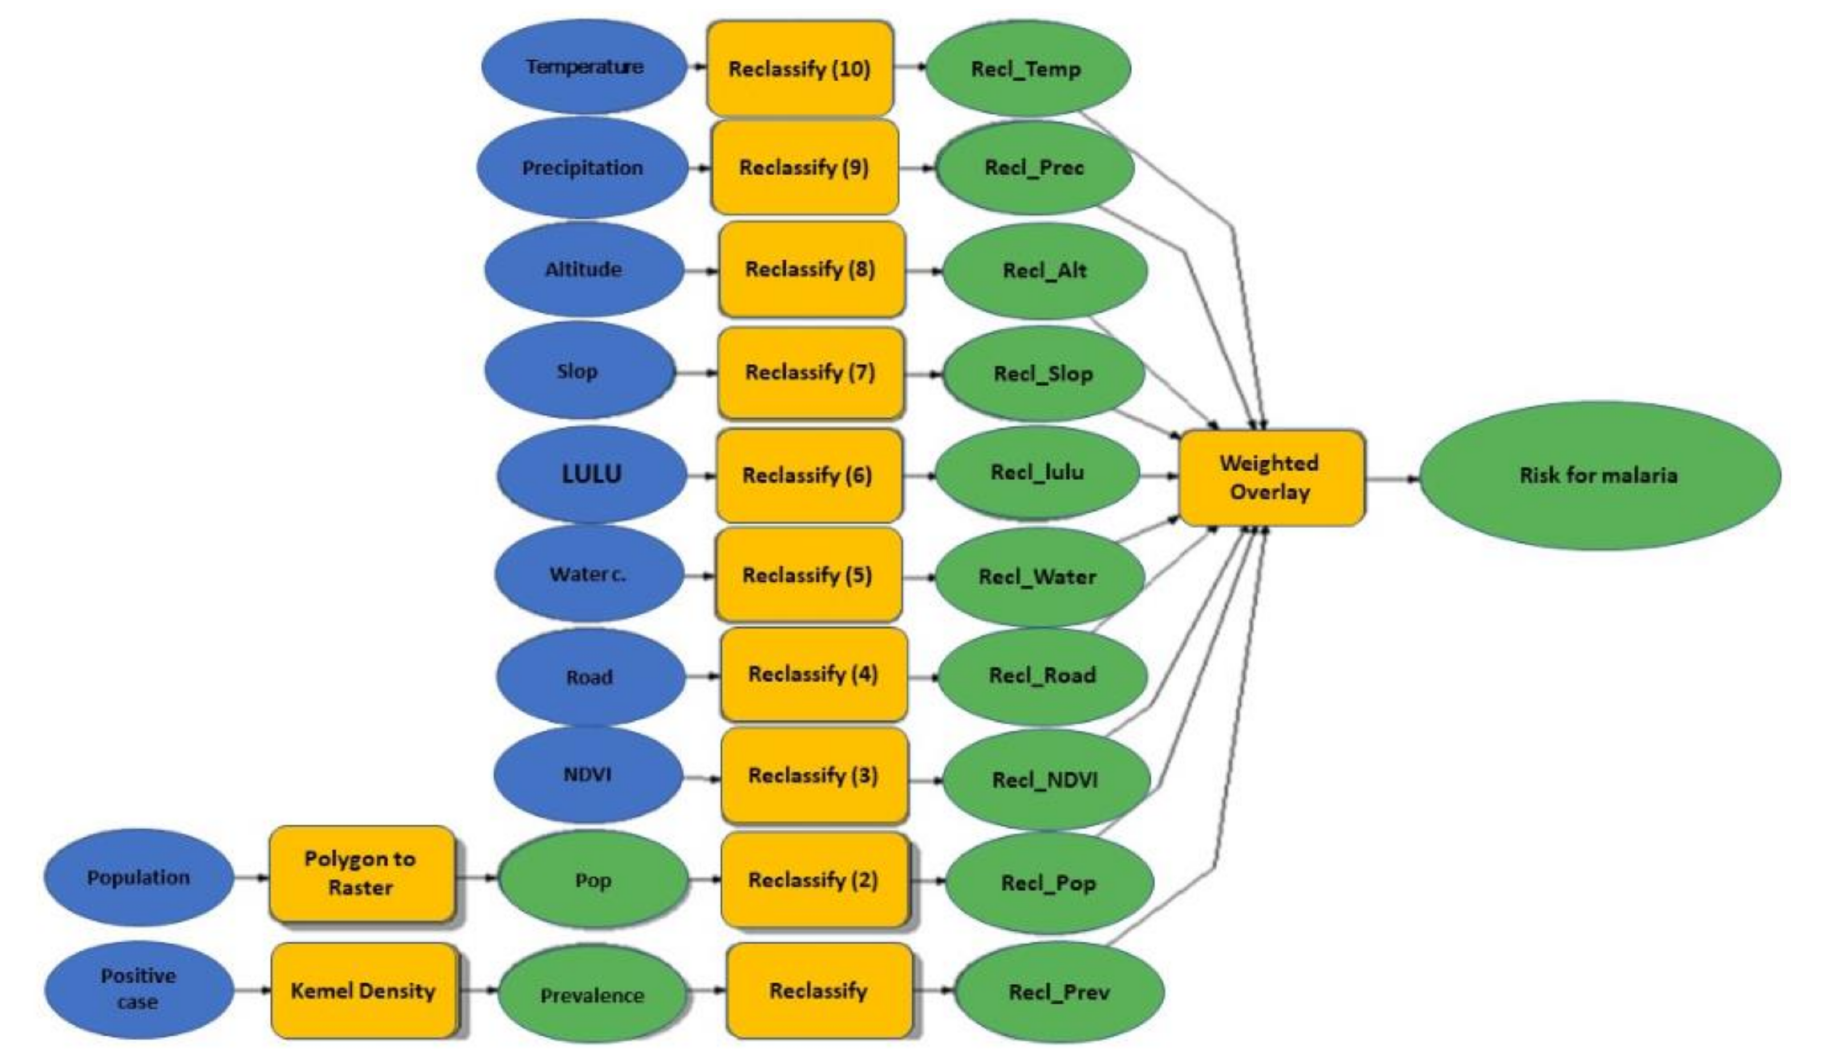
Figure 5. Schematic representation of the data flow and analysis to generate a malaria risk map in the Sussundenga